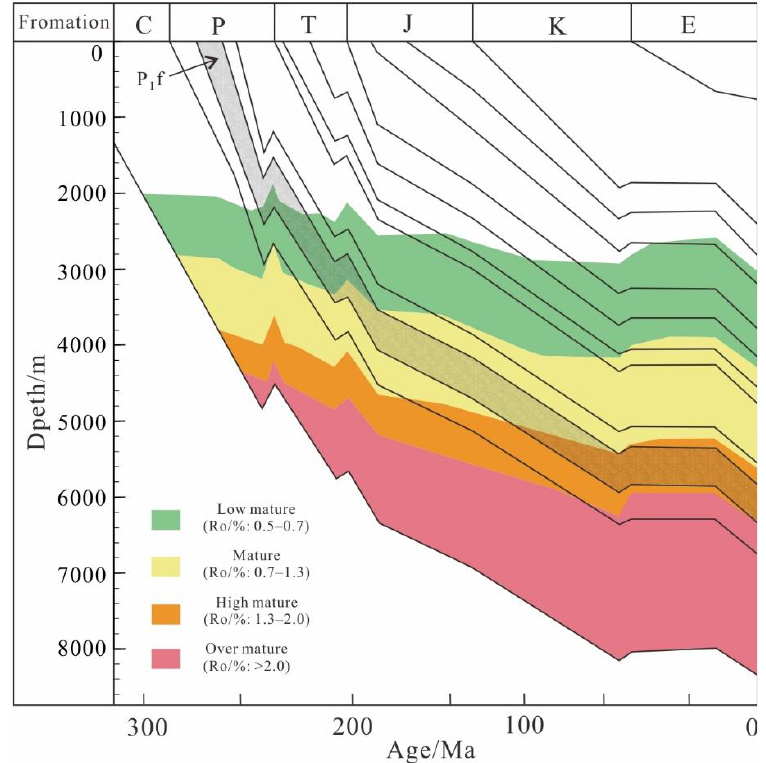
Figure 11. Burial thermal evolution history of sedimentary center in Mahu Sag.